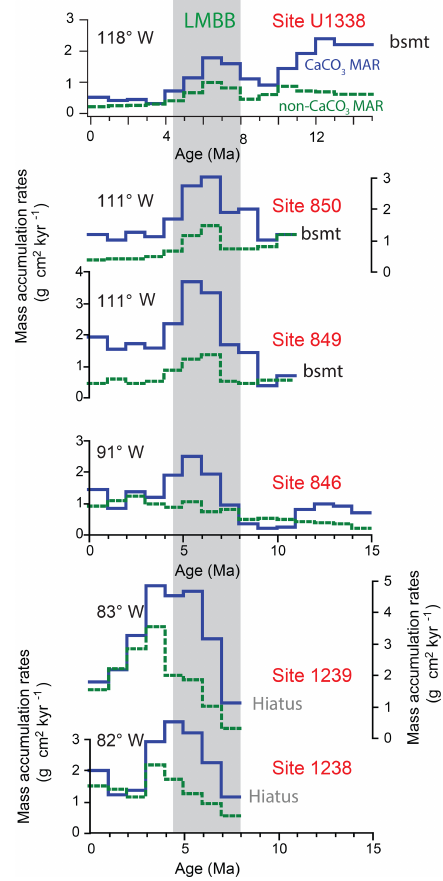
Figure 8. 1Myr increments of CaCO 3 MAR (blue lines) and non- CaCO 3 MAR (dashed green lines) on a longitudinal equatorial tran- sect from 118 to 82 ◦ W, near Ecuador. Non-CaCO 3 deposition is mostly biogenic silica at these drill sites. Basement is marked by “bsmt”. Data for U1338 are from this paper, while the other data are from ODP Leg 202 Shipboard Scientific Party (2003). The 8– 4.5Ma LMBB window is shaded. The end of peak CaCO 3 deposi- tion is roughly 2 million years younger near South America than in the west. Eastern Pacific drill sites (sites 846, 1238, and 1239) have increased biogenic deposition post-LMBB, presumably because of nutrient concentration after the Central American Seaway